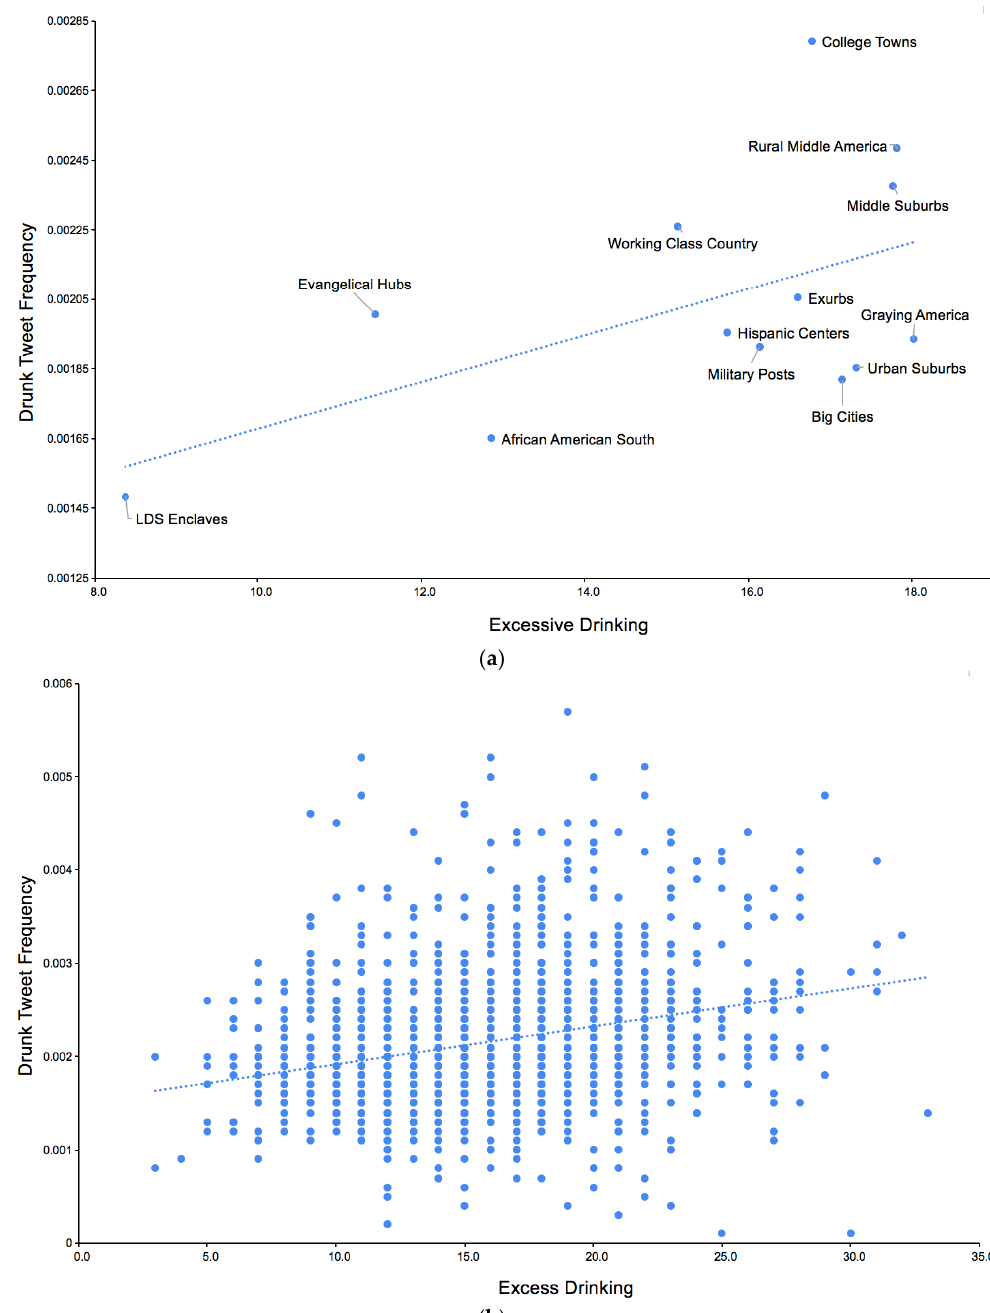
Figure 2. Frequency of drinking tweets versus excessive drinking levels: ( a ) ACP classification (county averages) and ( b ) county level.